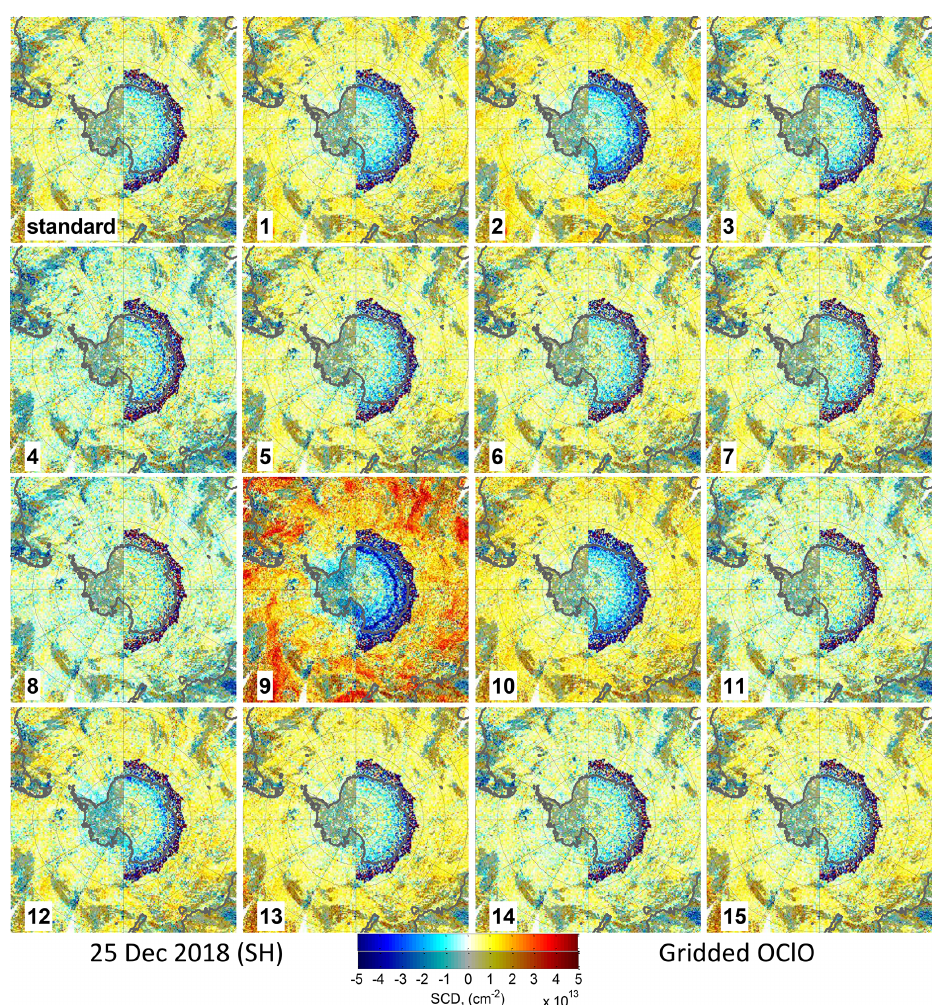
Figure B6. Same as Fig. B4 but for 25 December 2018 in the SH. Note the different treatment with respect to the descending orbit parts (with higher SZAs): in the western hemisphere, only data for the ascending parts are shown, while in the eastern hemisphere data of the descending parts are plotted when